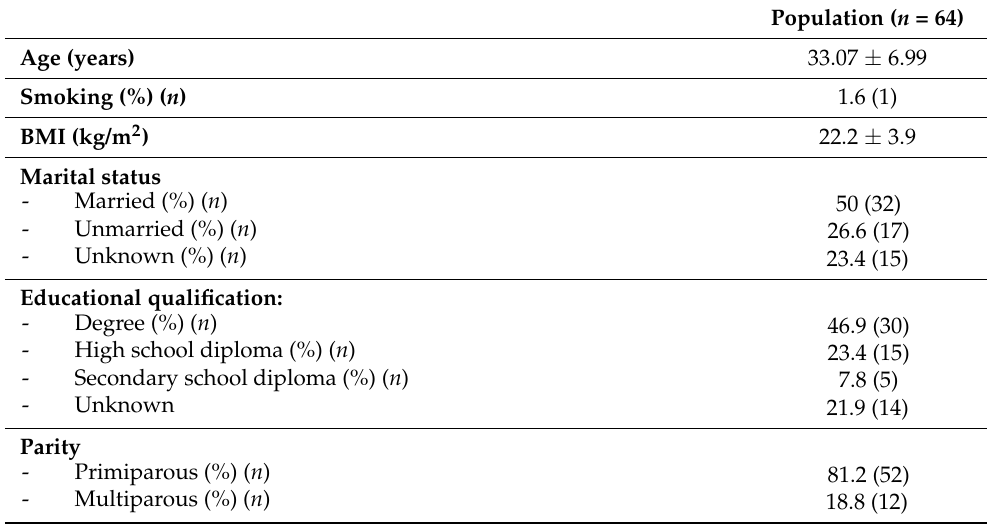
Table 1. Socio-demographic and obstetrical